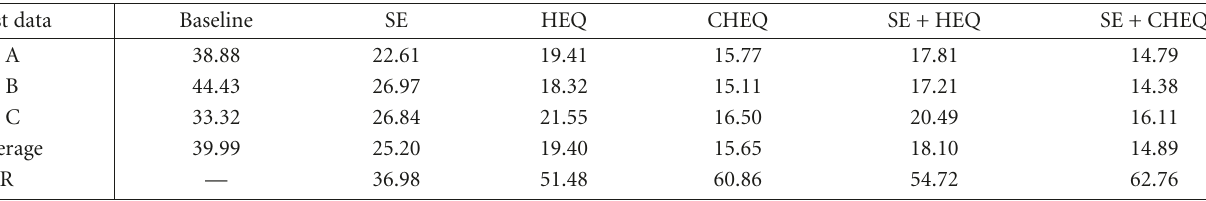
Table 1: Average WERs (%) of various acoustic compensation techniques on the Aurora2 task (clean-condition training, averaged between 0–20 dB